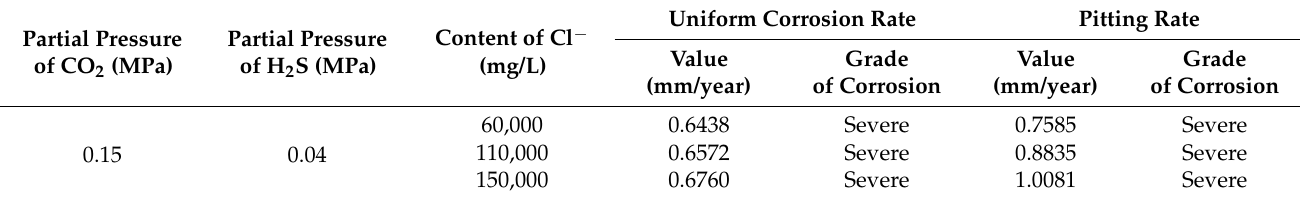
Table 9. Experimental results of experimental conditions 3.